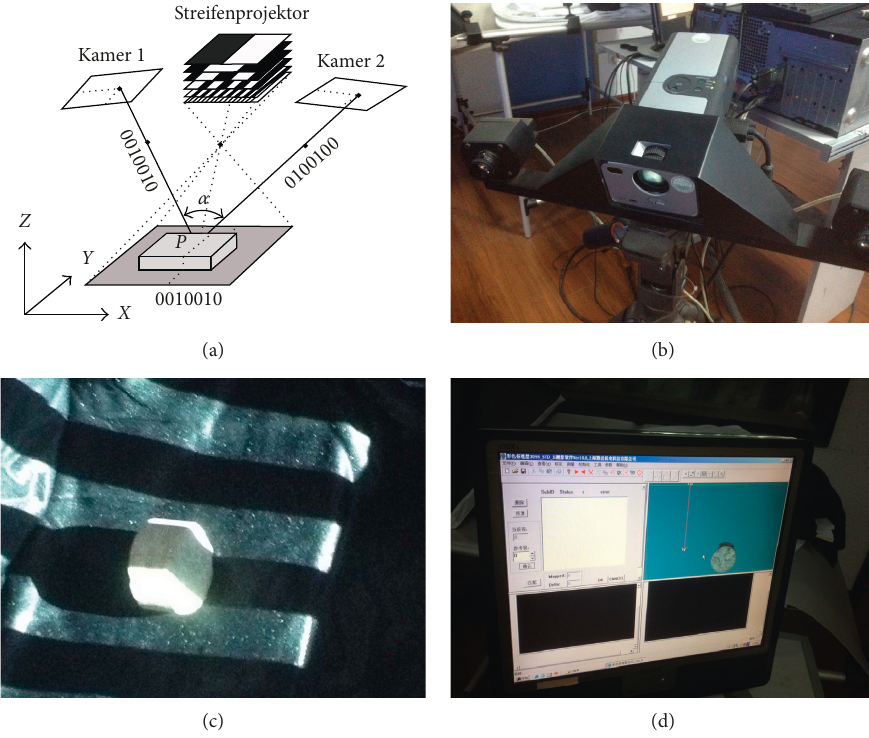
Figure 4: Scanning and identification of the original samples using the 3DSS device. (a) Principal of scanning; (b) equipment of scanning (3DSS); (c) rock sample; (d) postprocessing system.